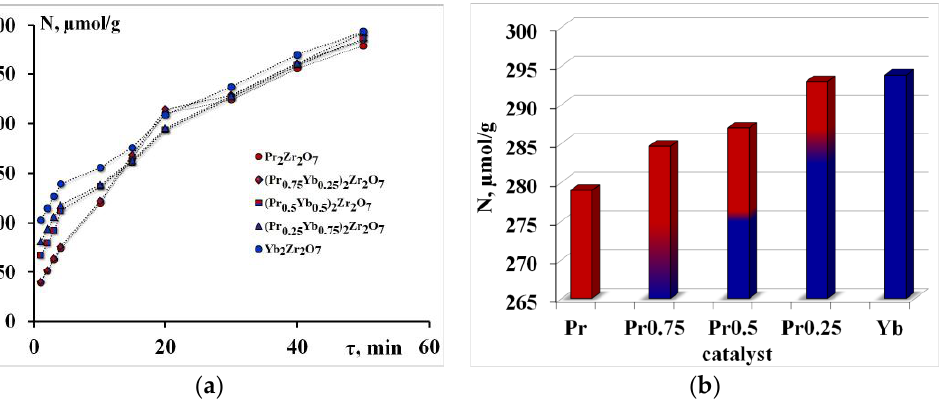
Figure 2. Pyridine adsorption isotherms — ( a ), the number of electron-withdrawing centers — ( b ). The initial section of these curved lines corresponds to adsorption on “ strong ” acids.